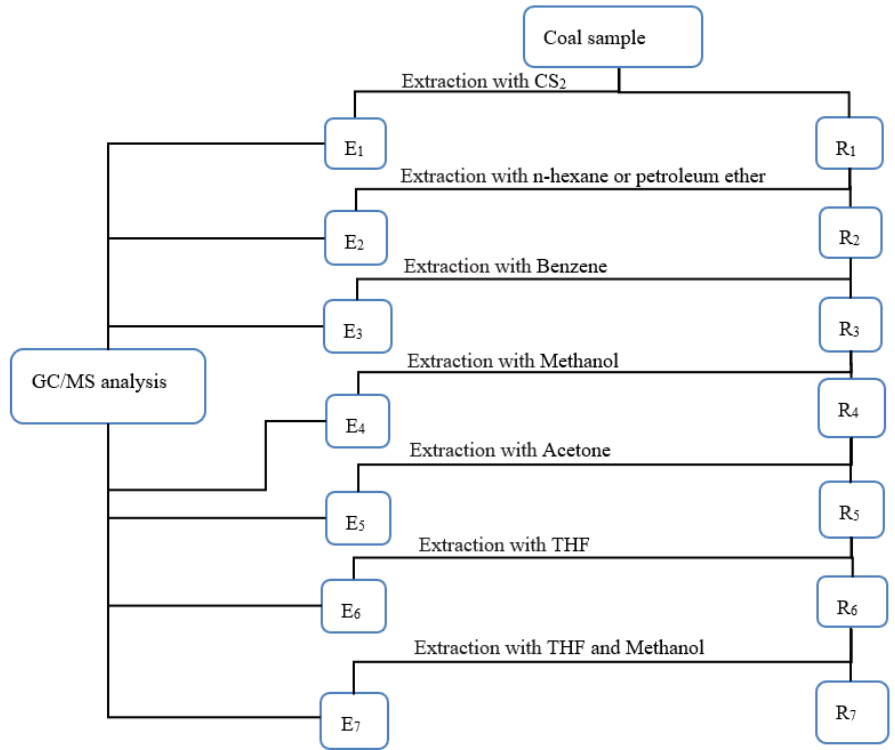
Figure 1. Procedure of Soxhlet extraction: E1: CS2 extract; E2: n-hexane or petroleum ether extract;